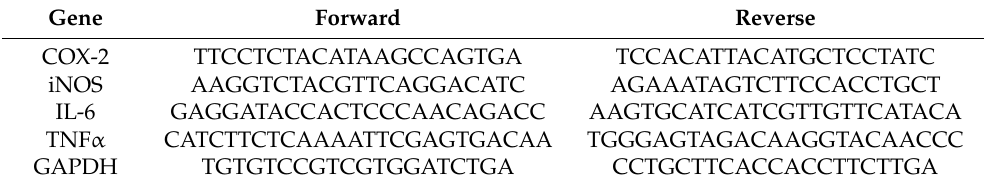
Table 3. Primer sequences for pro-inflammatory mediator expression in